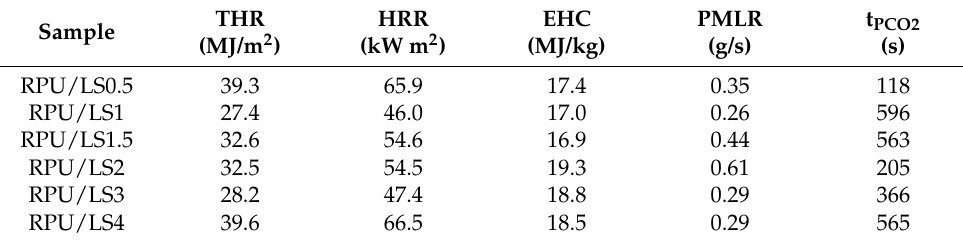
Figure 6. LOI ( a ) and THR ( b ) curves of RPU/LS foams. Table 6. Effects of LS ratios as a char forming agent for the flame retardancy of RPU/LS foams.